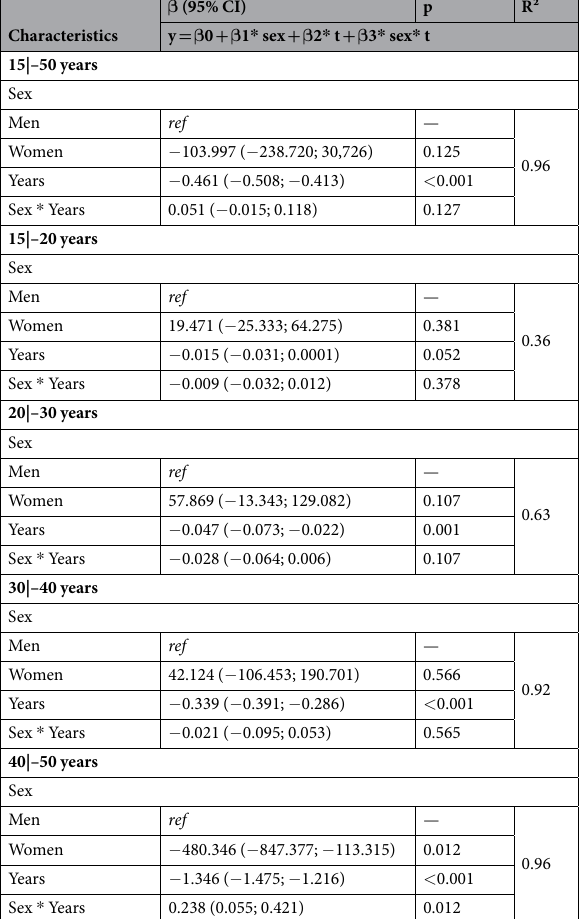
Characteristics